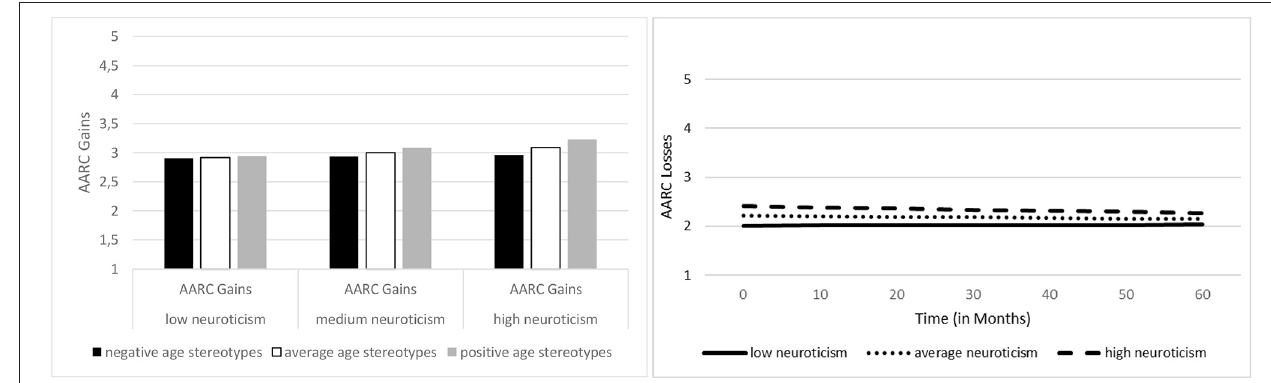
FIGURE 3 | Associations of neuroticism with general AARC gains, by age stereotypes, and with general AARC losses. Left Figure: Both greater neuroticism and more positive age stereotypes predicted higher general AARC gain scores at baseline. Additionally, the interaction of neuroticism with age stereotypes reached statistical significance, indicating that the association between greater neuroticism and higher AARC gain scores was stronger among individuals who had more positive age stereotypes. Right Figure: Individuals scoring higher on neuroticism reported greater general AARC losses at baseline, but, at the same time, decline in AARC losses over time was also steeper among those scoring higher on